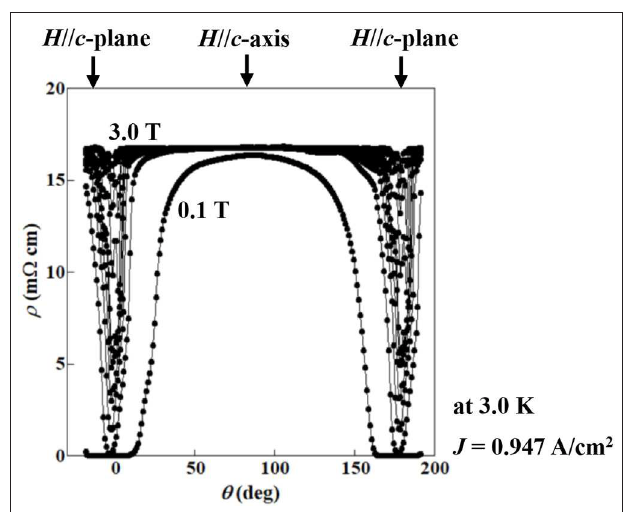
FIGURE 10 | Angular ( θ ) dependence of resistivity ( ρ ) in flux liquid state at 3.0K under various magnetic fields H = 0.1–3.0T for (Ce,Pr)OBiS 2 with x = 0.9 single